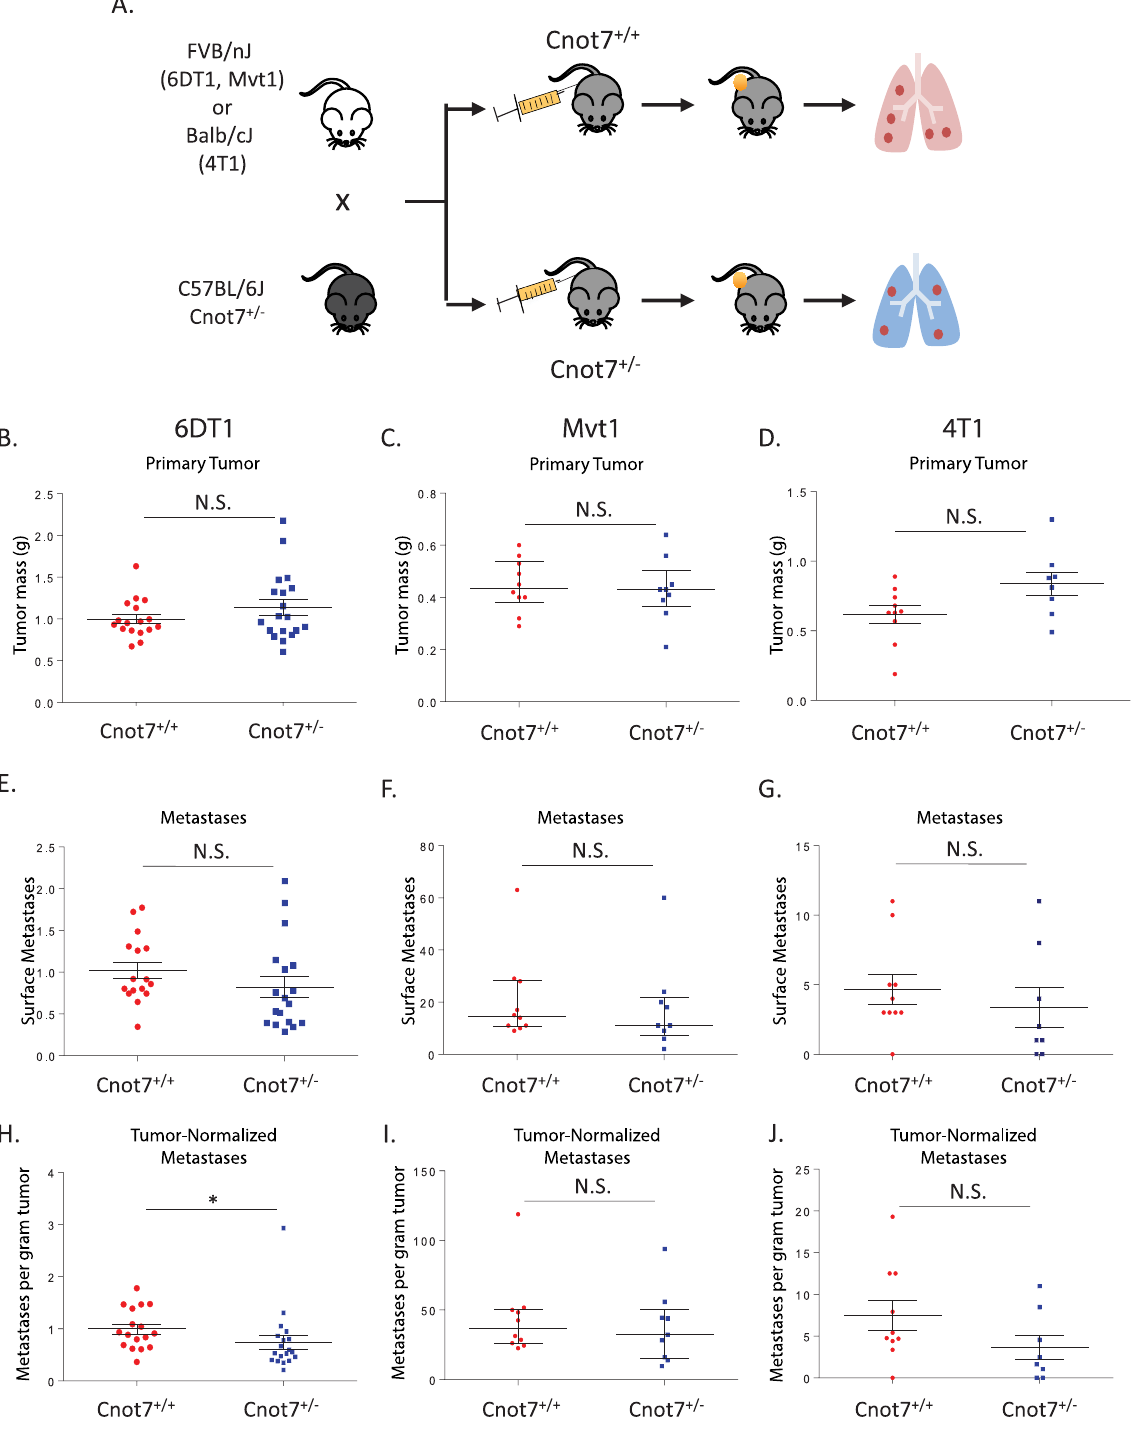
Fig 3. Design of the orthotopic implantation assays to test for stromal effects of Cnot7 knockdown (A). Dot plots showing the primary tumor mass of each animal are shown for the cell lines 6TD1 (B), Mvt1 (C) and 4T1 (D). Surface pulmonary metastasis counts for each cell line are displayed in panels E, F, and G. Metastasis counts after normalization by primary tumor burden are displayed in panels H, I, and J. N.S. = not significantly different. * = p < 0.05.